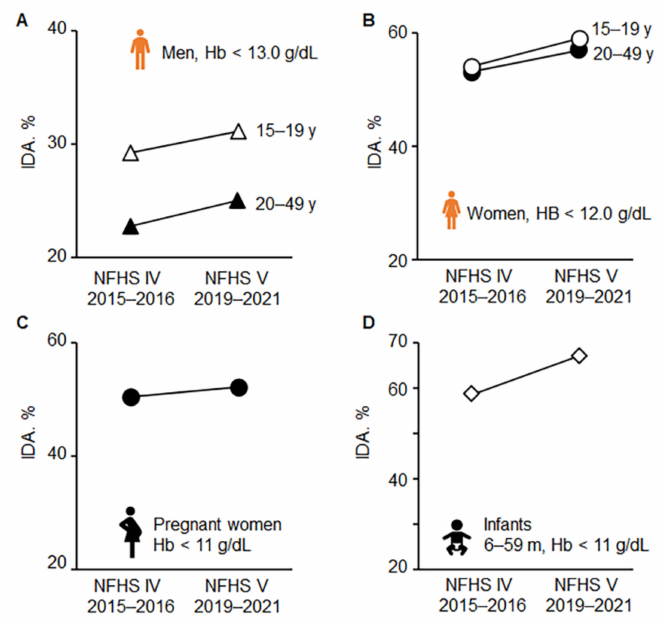
Figure 4. Increased prevalence of IDA from 2015 to 2021 in adolescent and adult men ( A ) and women ( B ) as well as in pregnant women ( C ) and infants ( D ) in India based on NFHS IV and V surveys. NFHS, National Family Health